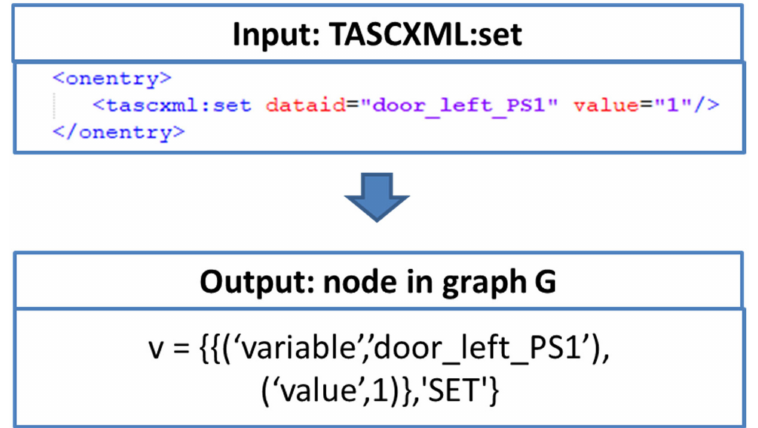
Figure 9. Example for mapping the TASCXML command set to a graph